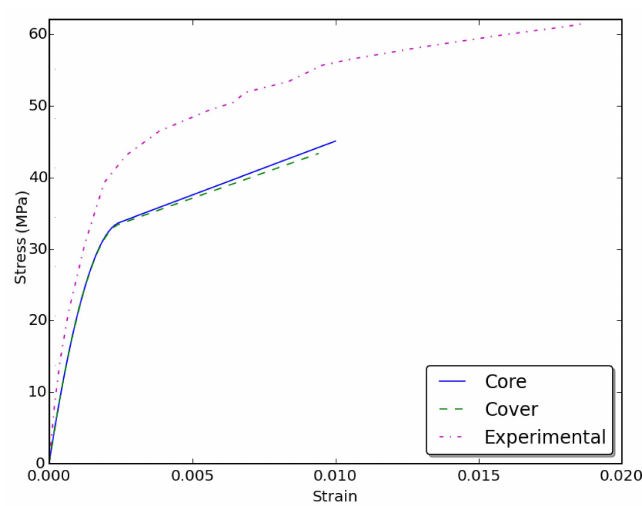
Figure 15. Stress-strain curves for specimen